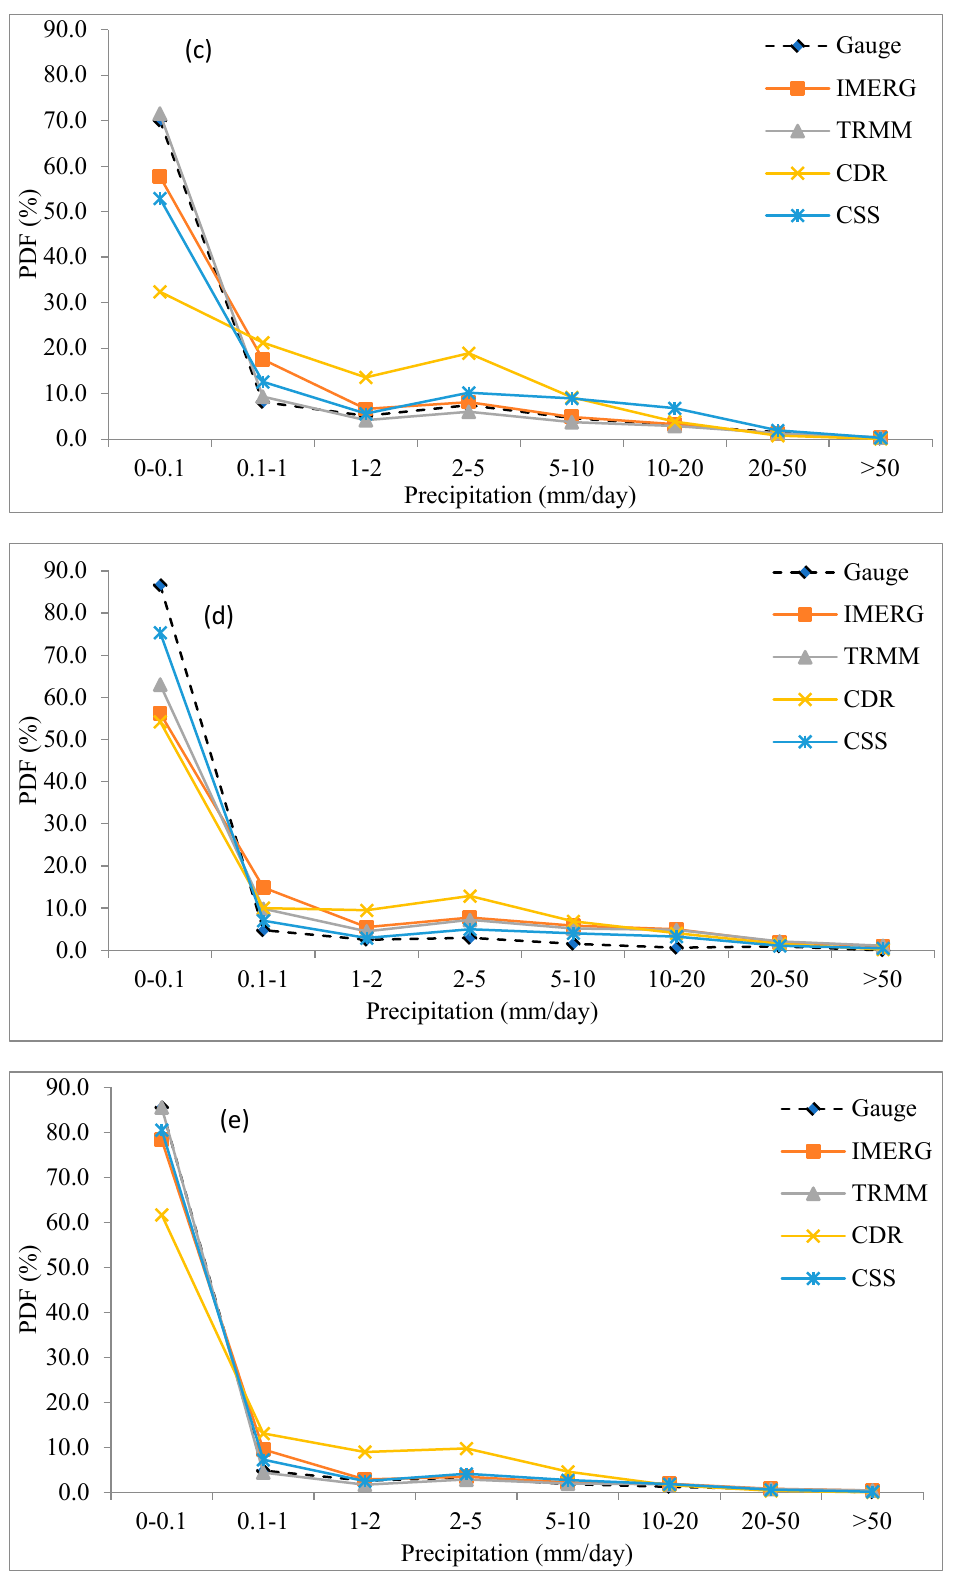
Figure 19. PDF (%) of all SBPD at ( a ) daily, ( b ) winter, ( c ) spring, ( d ) summer, ( e ) autumn scales over Tajikistan.